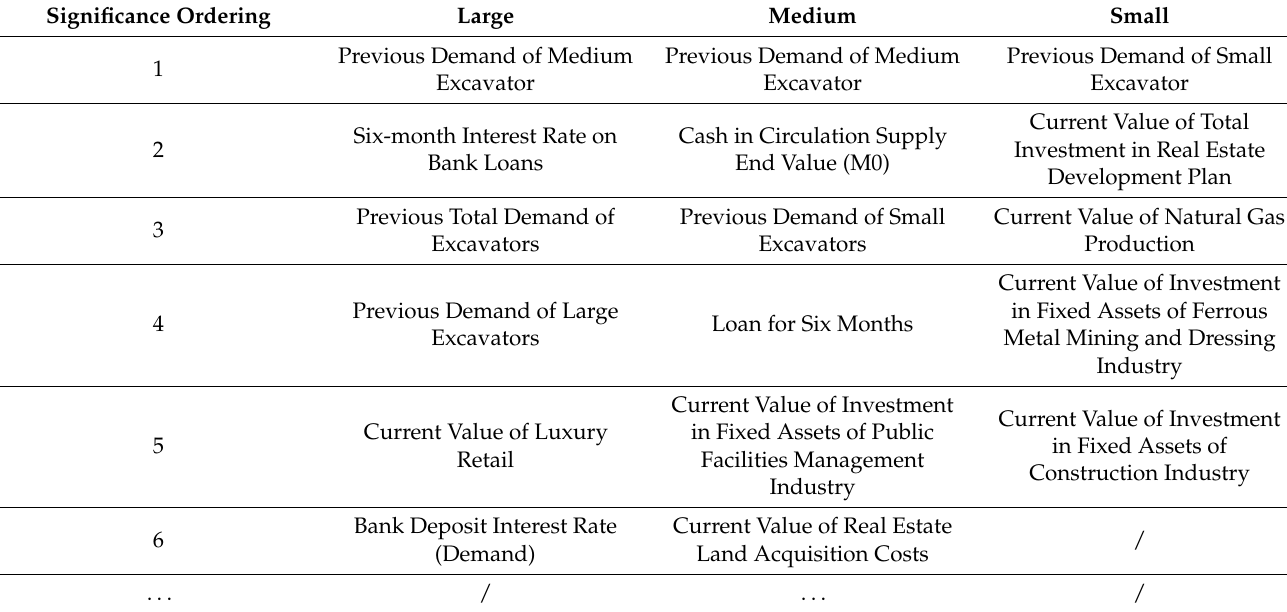
Table 3. Feature ranking of different types of excavators’ market capacity.